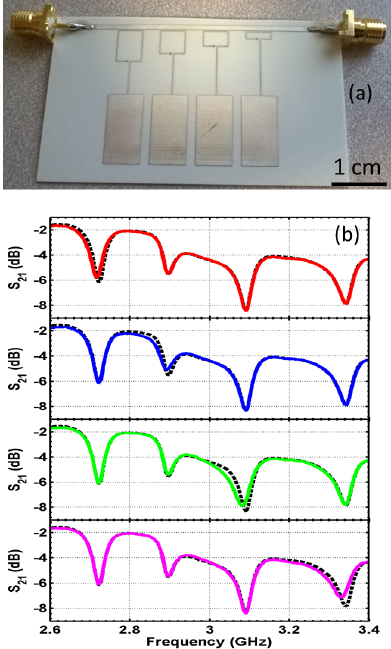
Figure 14. ( a ) The fabricated capacitive sensor array with microstrip-coupled split-rings; ( b ) experiment result on the fabricated sensor array. The four subfigures show the transmission spectrum with the object present at each of the capacitive sensors (colored solid curve), compared to transmission without the object (black dashed